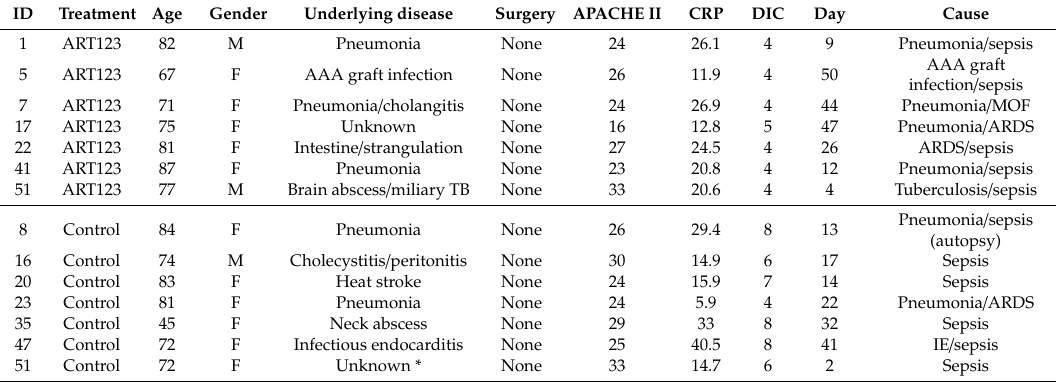
fresh frozen plasma, anticoagulants, and / or antithrombotics have been used in attempts to control life-threatening bleeding and coagulation disorders even though those treatments might not be meaningful. This dilemma is similar to that of the cardiac arrhythmia suppression trial (CAST). Arrhythmia can be life-threatening after myocardial infarction, and cardiologists thought suppressing frequent premature ventricular contractions after a heart attack using antiarrhythmics could improve mortality. Ironically, the mortality rate significantly increased with antiarrhythmics despite the reduction of premature ventricular contractions, and the trial was discontinued [23]. Based upon recent clinical trials, including ours, ART-123 may not be harmful, but it does have a substantial impact on medical